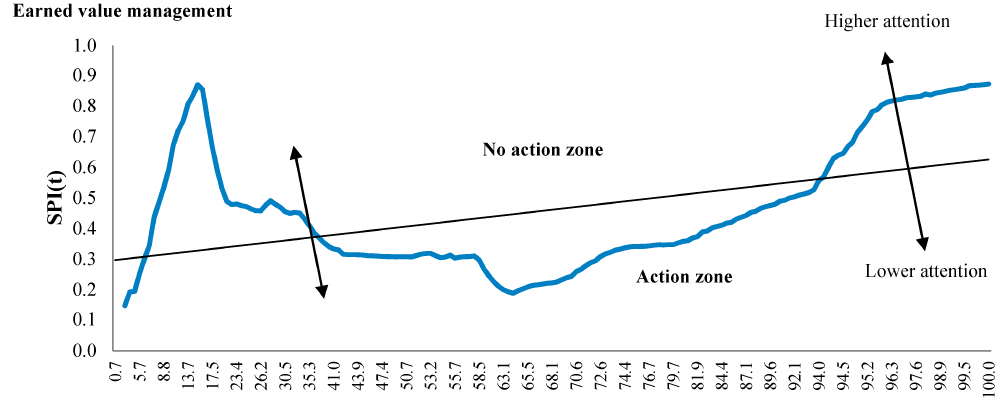
Figure 21. Corrective action during project control.